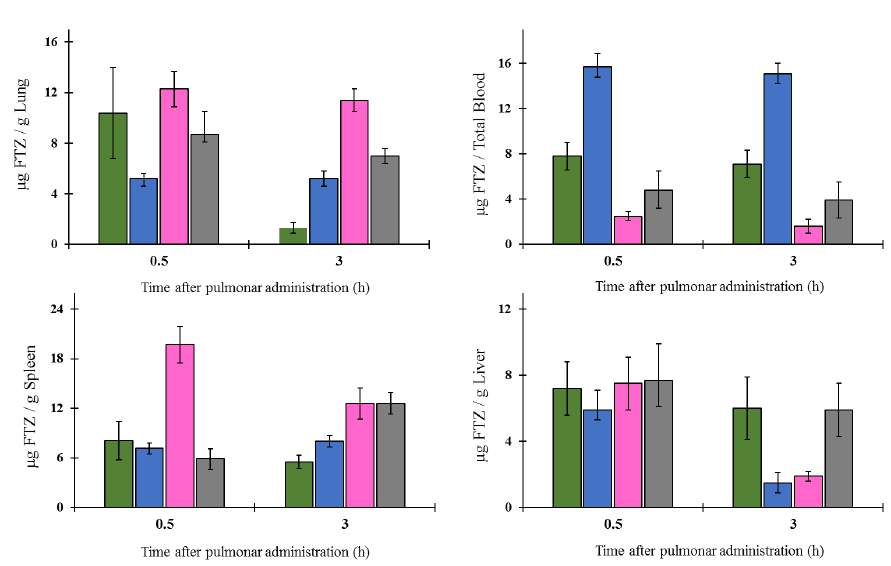
Figure 6. Biodistribution profile of FTZ in the lung, blood, spleen, and in the liver after inhalation of FTZ in free form (grey columns) or incorporated in Ac-CyD (green columns), γ -CyD (blue columns), or in HP-CyD (pink columns). Mice were exposed to formulations for 5 min and were sacrificed 0.5 or 3 h after pulmonary delivery of dry powders under study. The obtained results are expressed as mean ± SD ( n = three mice per selected time and per FTZ formulation).